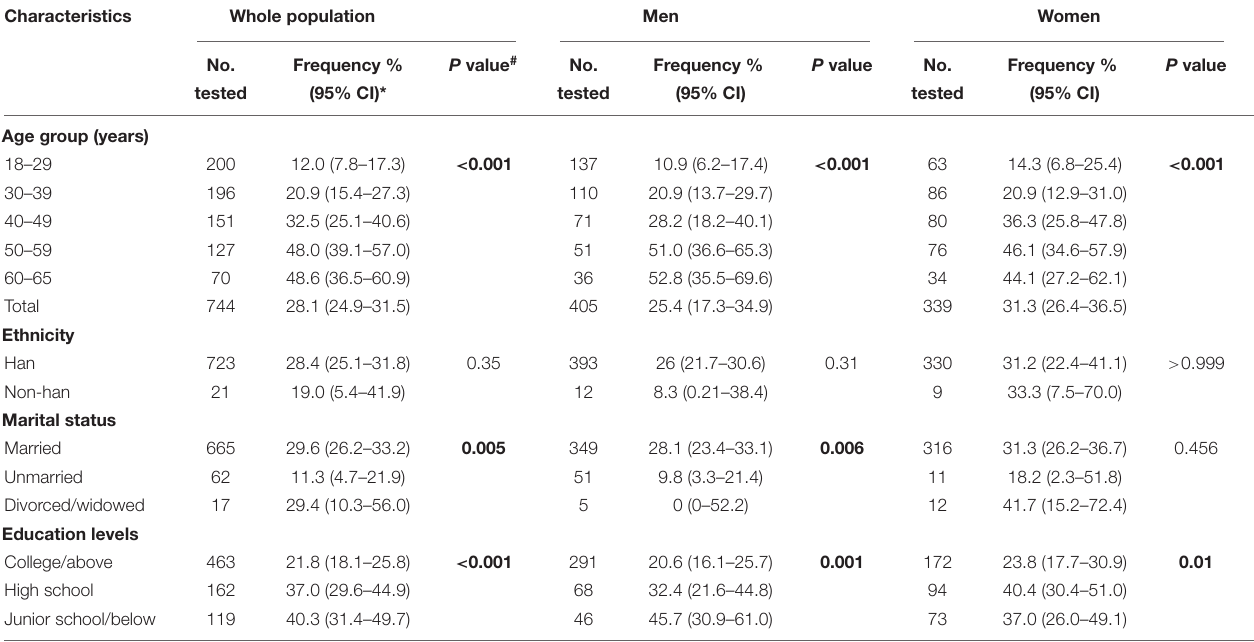
*95% “exact” Clopper-Pearson confidence interval of the frequency, estimated by the MedCalc software. # P values were calculated using chi-square tests with SPSS version 22.0 statistical software. Bold values indicate statistically significant associations, with P < 0.05.